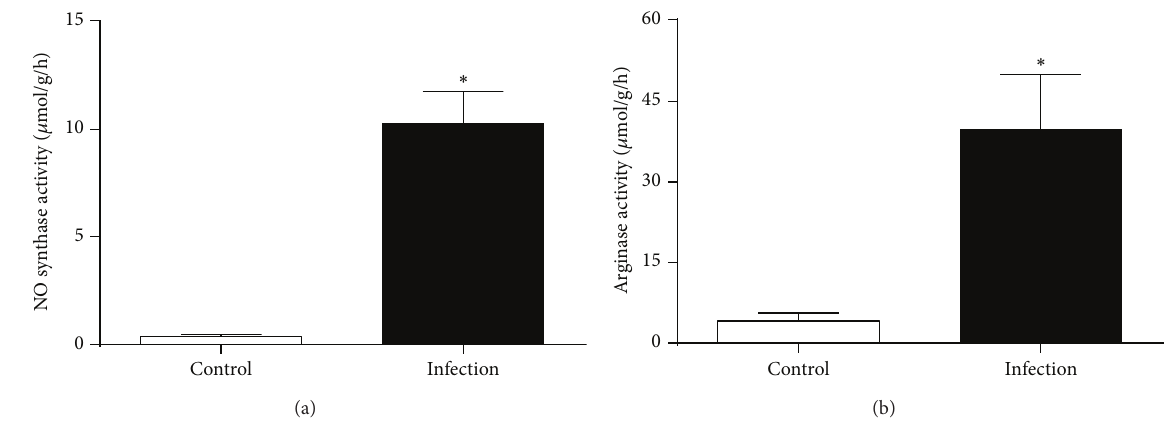
Figure 4: (a) Nitric oxide synthase (NOS) and (b) arginase activity in mouse lung calculated from stable isotope conversion in an isolated lungperfusionmodel.NOSandarginaseactivityweresignificantlyincreasedthreedaysafterdirecttrachealinstillationof Pseudomonas -laden agarose beads (infection) compared to control ( ∗ 𝑃 < 0.001 , resp.).